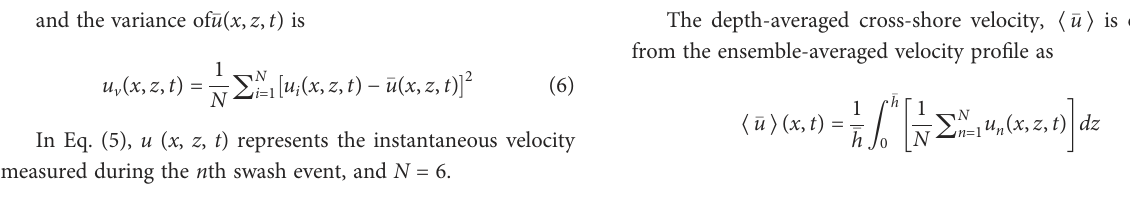
In Eq. (5), u ( x , z , t ) represents the instantaneous velocity measured during the n th swash event, and N = 6.